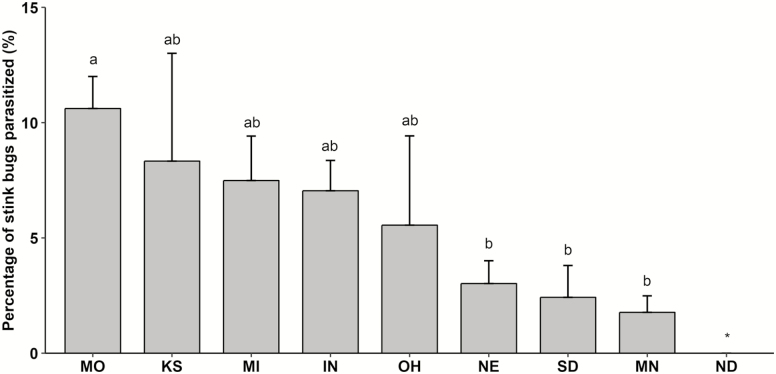
Mean (±SEM) percentage tachinid parasitism for a total of 1,968 stink bugs collected in soybean sweep samples from nine states in the North Central Region of the United States. Means with same letters are not significantly different at α = 0.05 using Tukey–Kramer-adjusted pairwise comparisons of least square means. An asterisk (*) indicates no parasitism observed for that state (IN = Indiana, KS = Kansas, MI = Michigan, MN = Minnesota, MO = Missouri, NE = Nebraska, ND = North Dakota, OH = Ohio, SD = South Dakota).